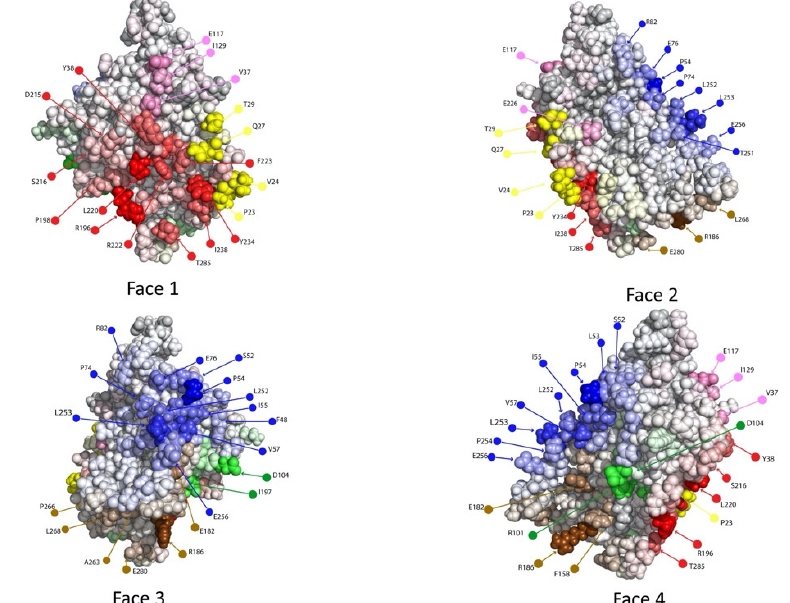
Figure 6. Antigenic heat map for Abs vs. gD2. Each residue is colored according to the Ab community (Figure 5) with which it has the most interactions and shaded so that residues with more interactions are colored more darkly. Face #1 is the nectin binding face. Faces #2–4 are rotated by 90, 180, and 270 degrees around the y -axis.